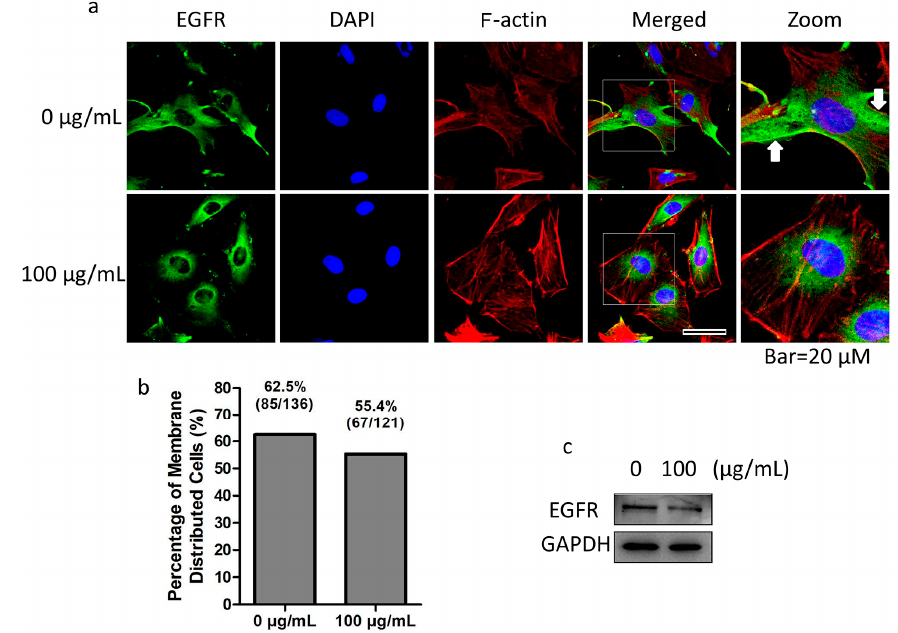
Figure 7. Fullerenol changes distribution pattern of epidermal growth factor receptor (EGFR). Adherent granulosa cells or oocyte-granulosa cell complexes (OGCs) were treated with or without 100 µ g/mL fullerenol for 2 h and then harvested or fixed. ( a ) Fullerenol treatment reduced EGFR membrane distribution in adherent granulosa cells (green, scale bar: 20 μ m). White squares indicate distinctive cells and are zoomed. White arrows indicate membrane-distributed EGFR; ( b ) Portion of adherent granulosa cells with EGFR membrane distribution; ( c ) Expression of EGFR in granulosa cells was not significantly altered after 100 μ g/mL fullerenol treatment for 2 h. Green, blue and red color indicate EGFR, nuclei staining and F-actin, respectively. At least three individual experiments were performed to detect EGFR levels.